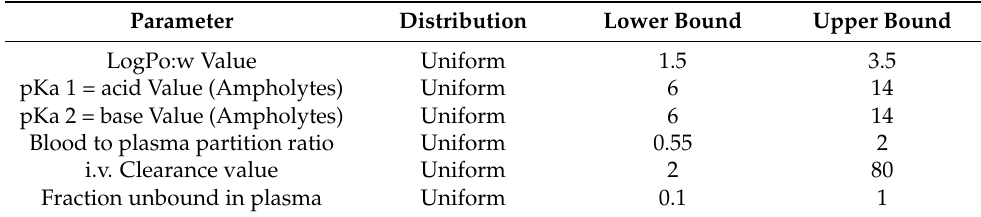
Table 2. Sensitivity analysis setup for antazoline metabolite model